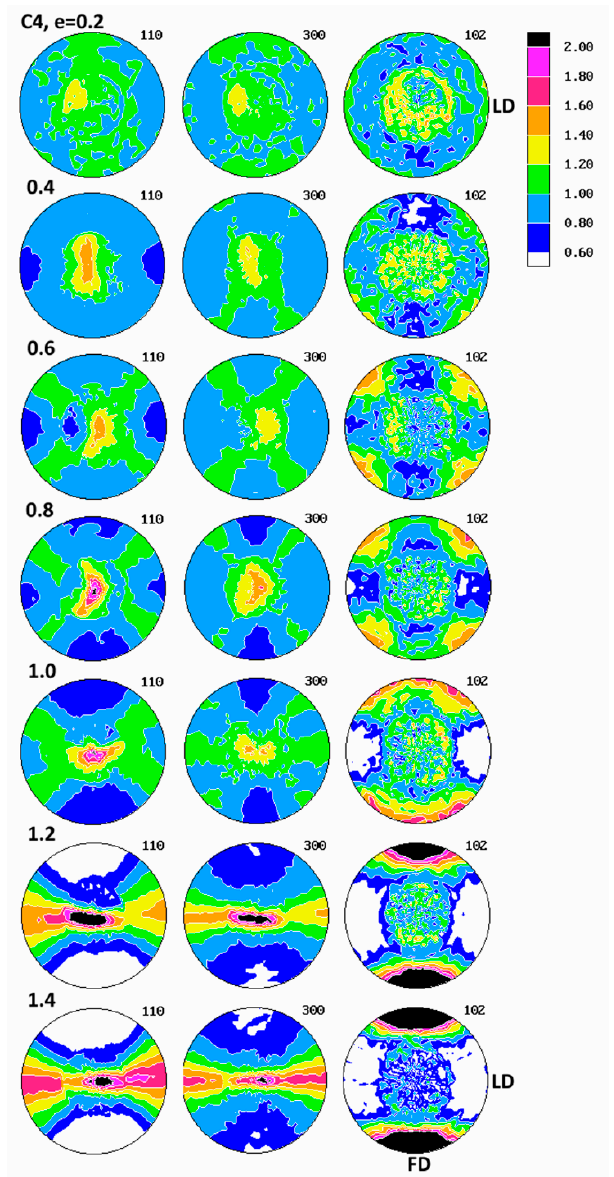
Figure 7. Normalized pole figures of the (110) (300) and (102) crystallographic planes (Form I) determined for samples of C4 copolymer compressed in plane-strain to the true strain indicated.